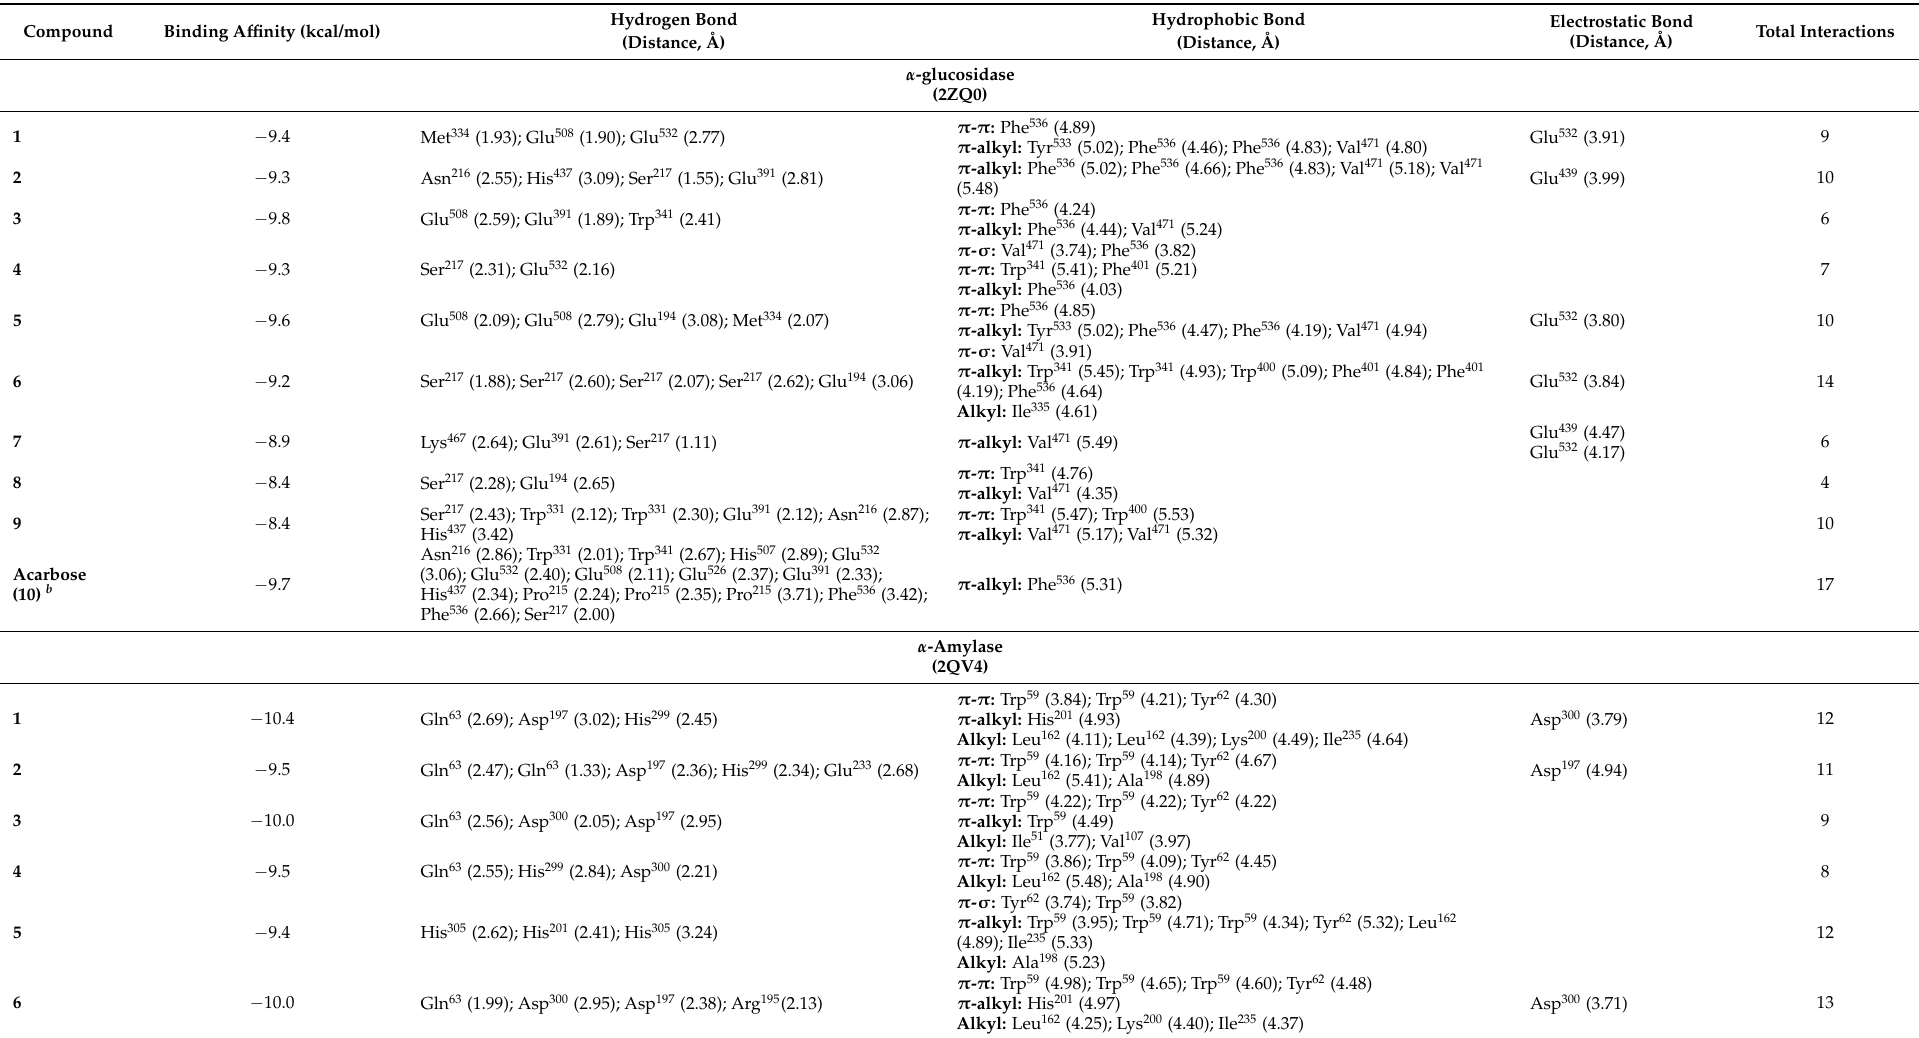
Table 4. Binding affinity and binding interactions of compounds 1 – 11 a to α -glucosidase, α -amylase and lipase